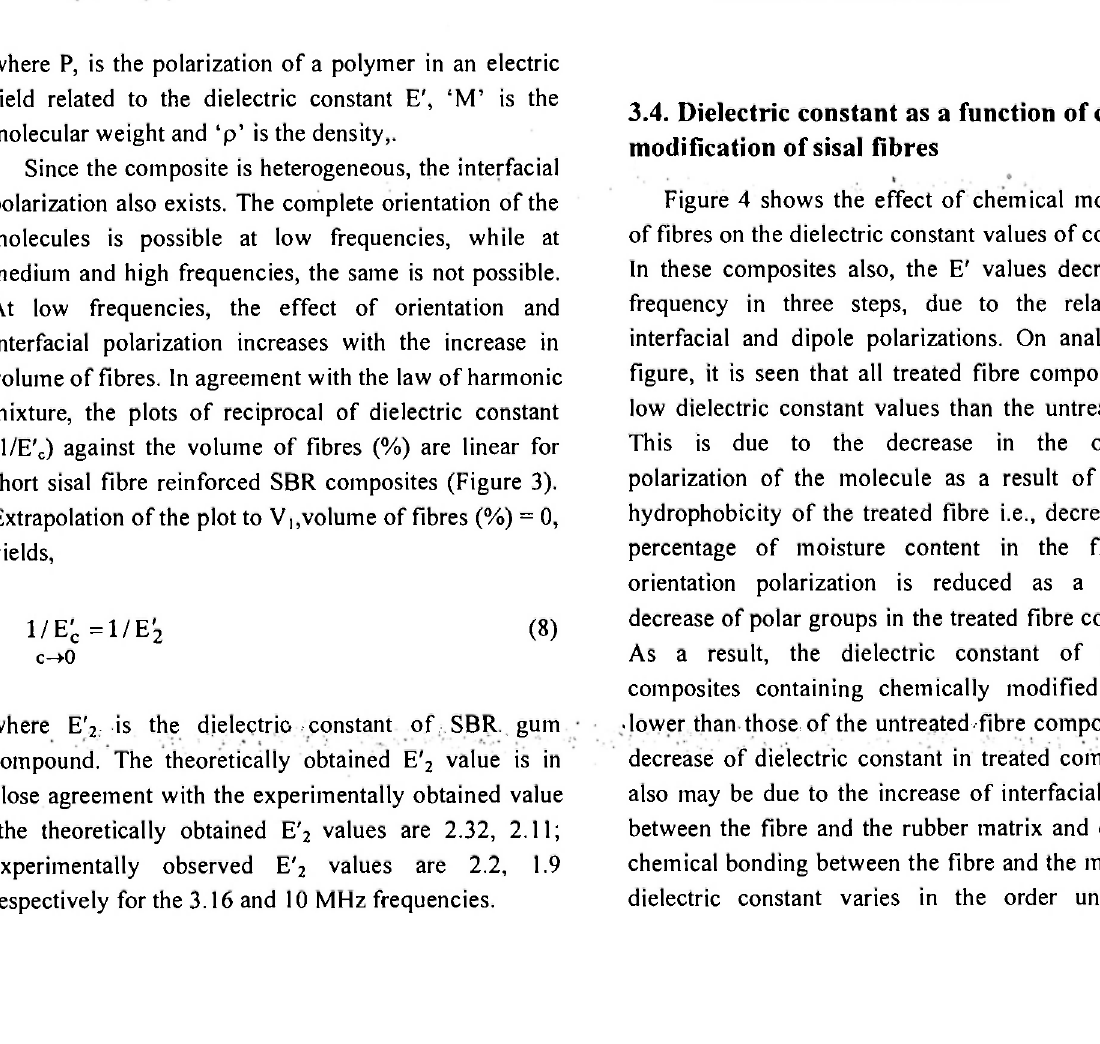
Fig. 3: Plot of reciprocal of dielectric constant as a function of volume of